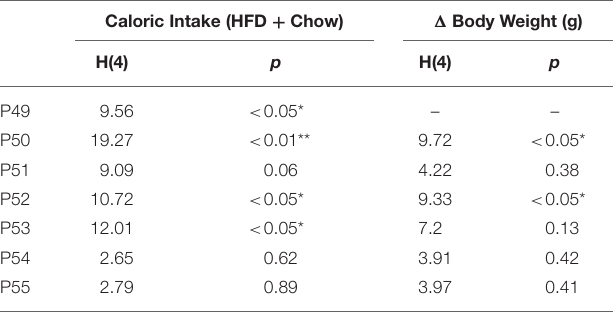
TABLE 3 | Kruskal-wallis test of significance of caloric intake and change in body weight during the 7-day HFD challenge. Caloric Intake (HFD + Chow) 1 Body Weight